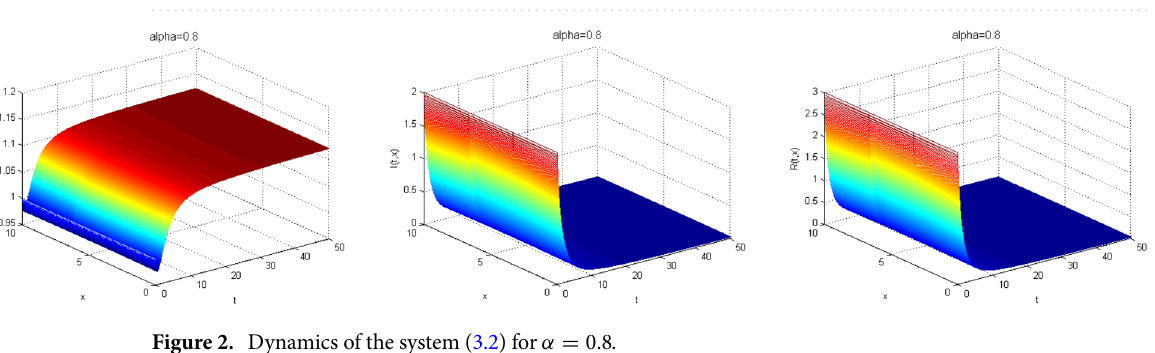
Figure 2. Dynamics of the system (3.2) for α = 0.8